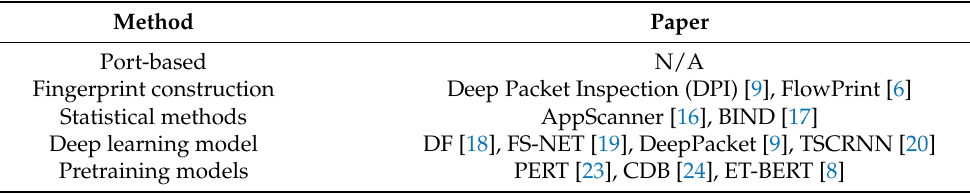
Table 1. Related work in encrypted traffic